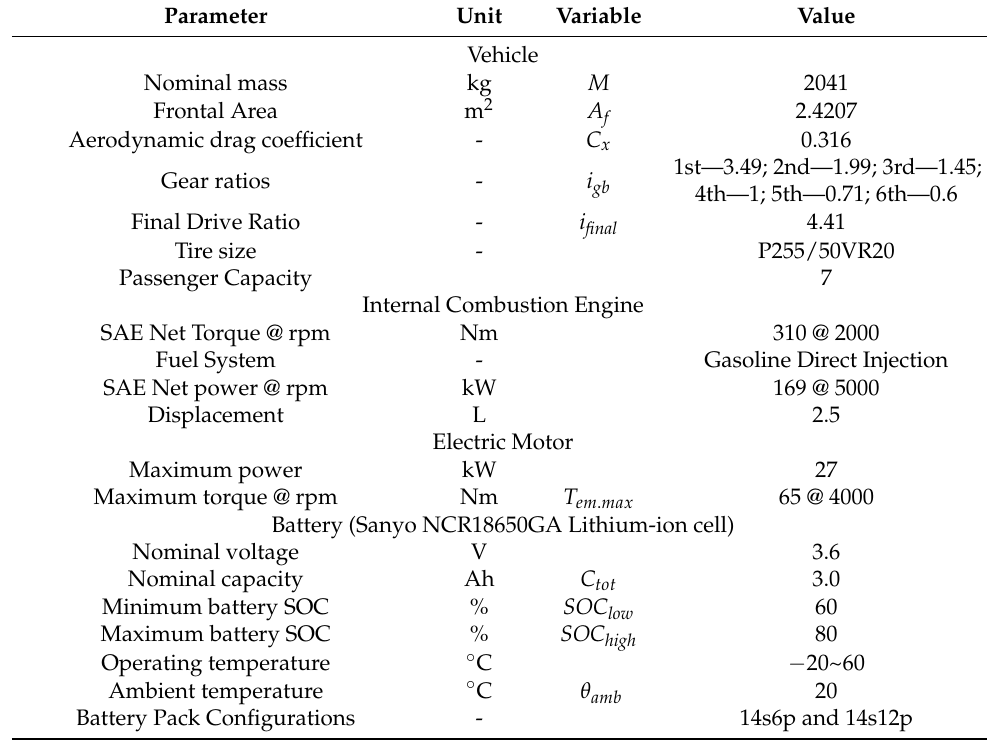
Figure 2. The scheme of backward simulator. Table 1. Mazda CX9 2016 [31].